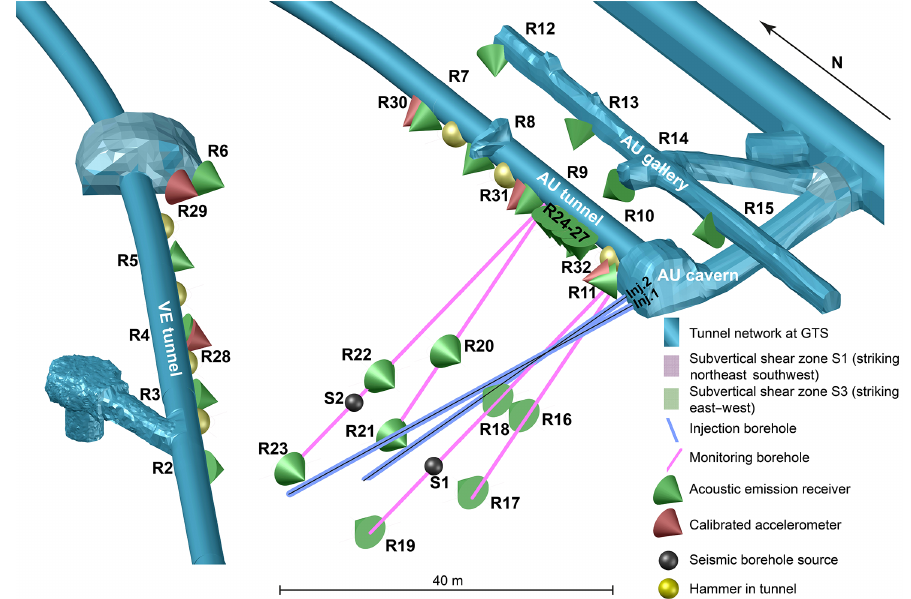
Figure 5. Outline of seismic monitoring network including hammer sources and borehole piezo sources for active seismic surveys.